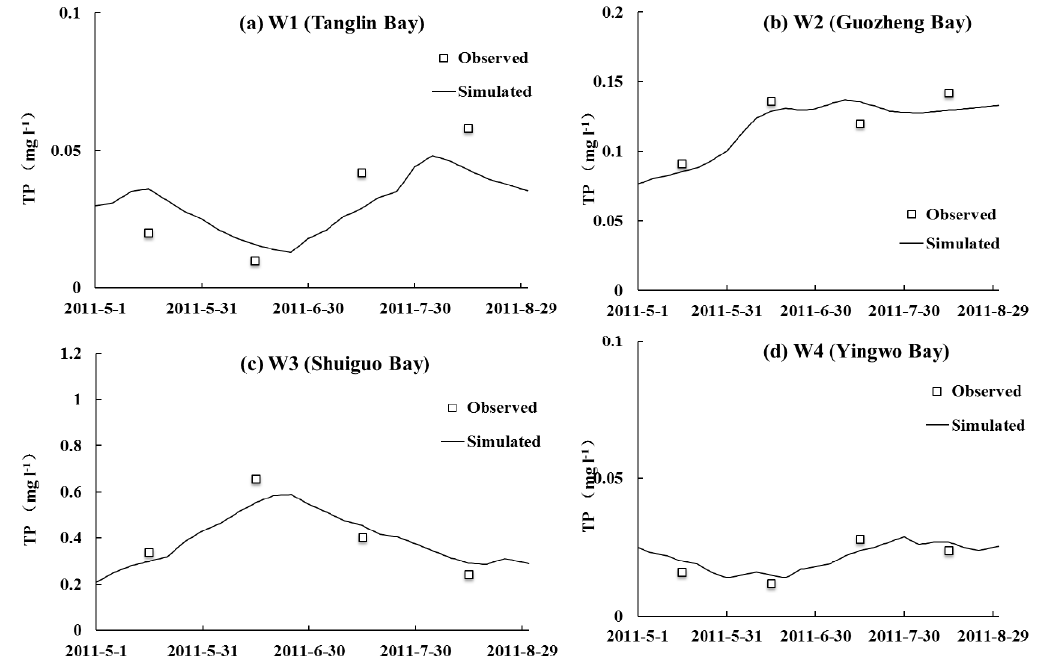
Figure 11. Comparison of simulated and observed TP at four bays: ( a ) Tanglin Bay; ( b ) Guozheng Bay; ( c ) Shuiguo Bay; and ( d ) Yingwo Bay.